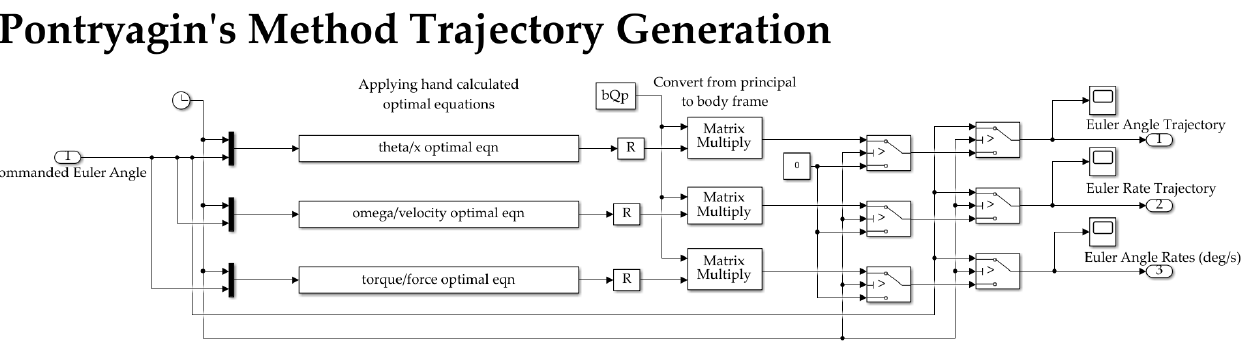
Figure A4. MatLab model with complete detailed display of optimal trajectory generation using Pontryagin’s method block in the trajectory Simulink subsystem.